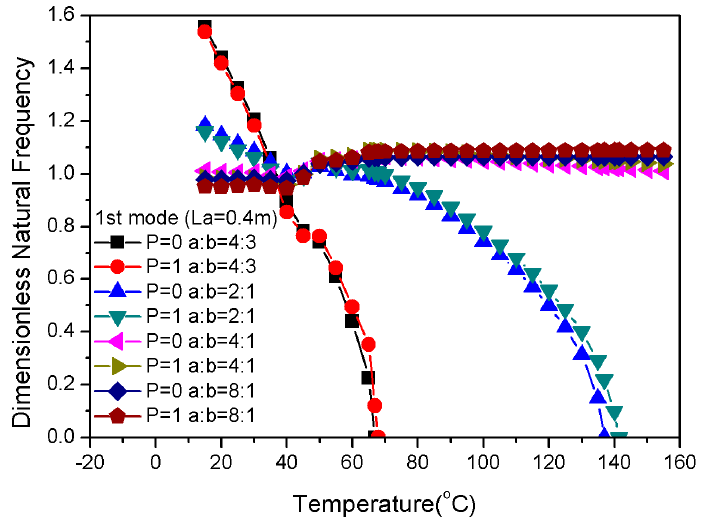
Figure 13. Dimensionless natural frequencies vs. temperature with variations of width.